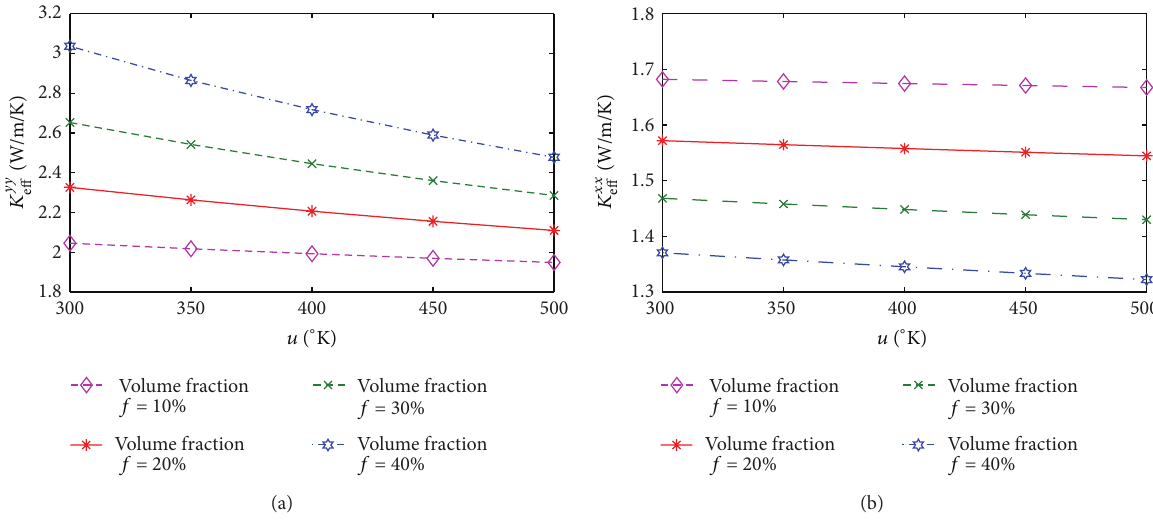
𝑦𝑦 as a function of temperature and volume fraction of inclusion: (a) case of perfect interface; (b) eff